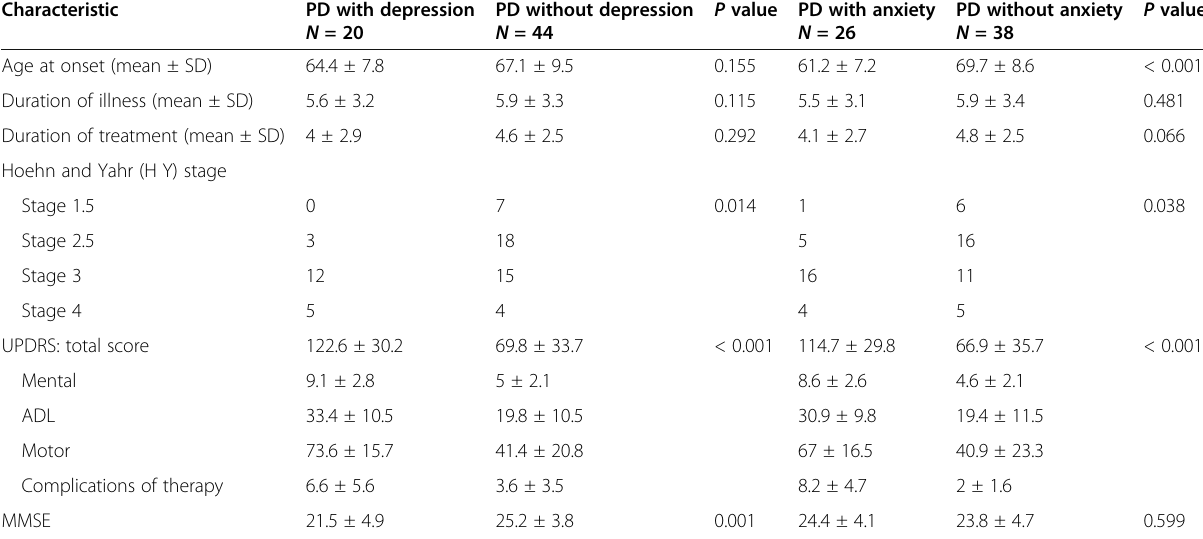
Table 3 Comparison between Parkinson ’ s disease patients with and without depression and those with and without anxiety in demographic and clinical